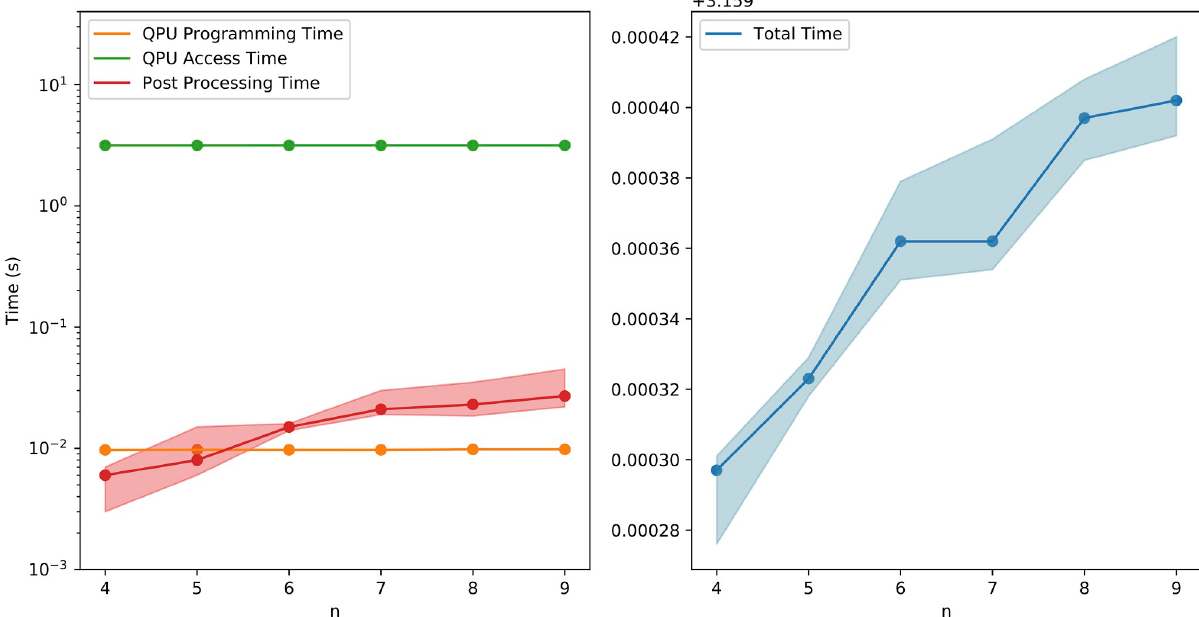
Fig 9. Benchmark times. Time taken per 10,000 samples for 4 � n � 9. Left: QPU programming time, QPU access time, and total post processing time. Right: total real time (+3.159 seconds). Note that the left panel is on a log scale.